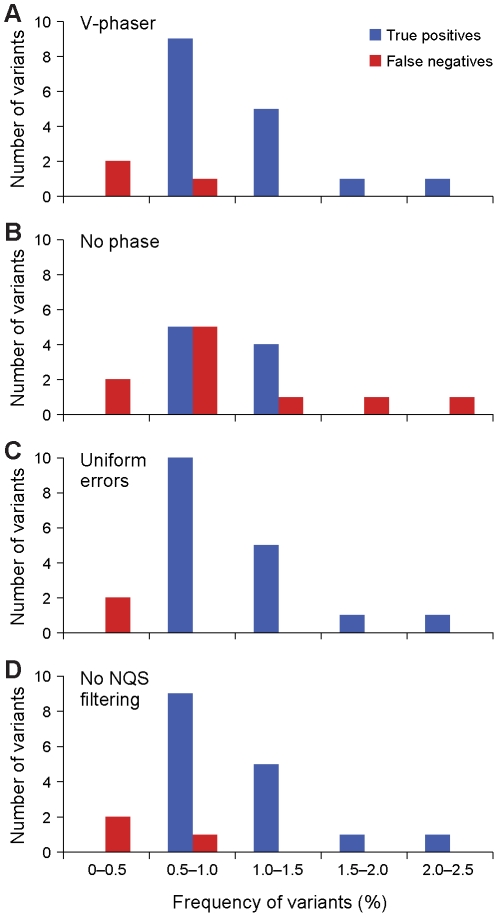
Phase information increased sensitivity to detect minor variants.Phase information increased sensitivity to detect low frequency variants, as shown by these histograms of variants under 2.5%. All versions of V-Phaser detected 100% of the variants above 2.5% frequency, so these variants are not shown here. All versions of V-Phaser with phase information (A), (C), and (D) detected most variants below 1% in frequency, but the No Phase version (B) missed many variants below 1% and some variants as high as 2.5%. Data are from control WNV mixed population.